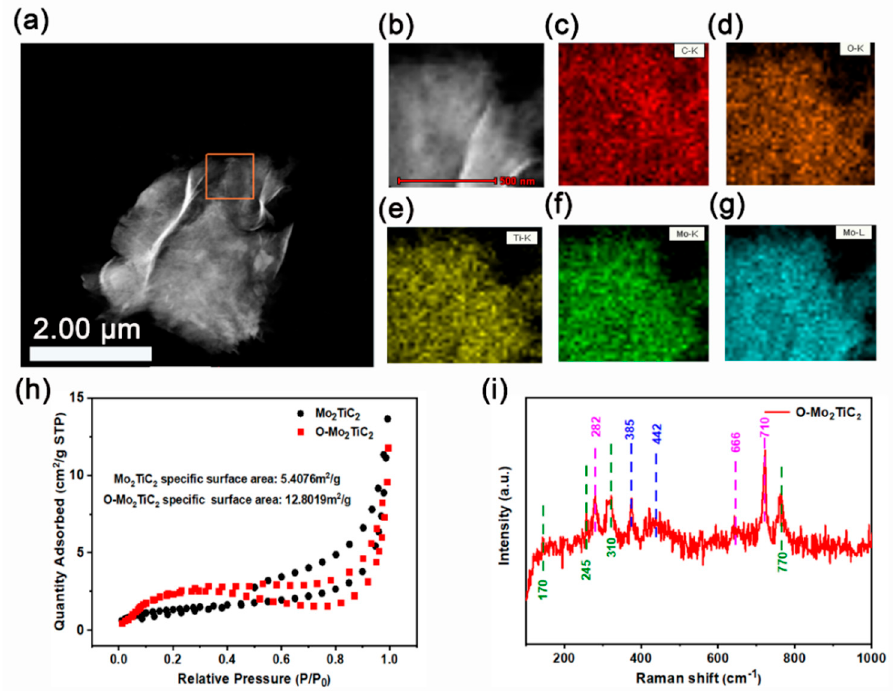
Figure 2. ( a − g ) EDX elemental mapping images of C, O, Ti, and Mo in O-Mo 2 TiC 2 . ( h ) N 2 adsorption– desorption isotherms for Mo 2 TiC 2 MXene and O-Mo 2 TiC 2 . ( i ) Raman spectra of O-Mo 2 TiC 2 .